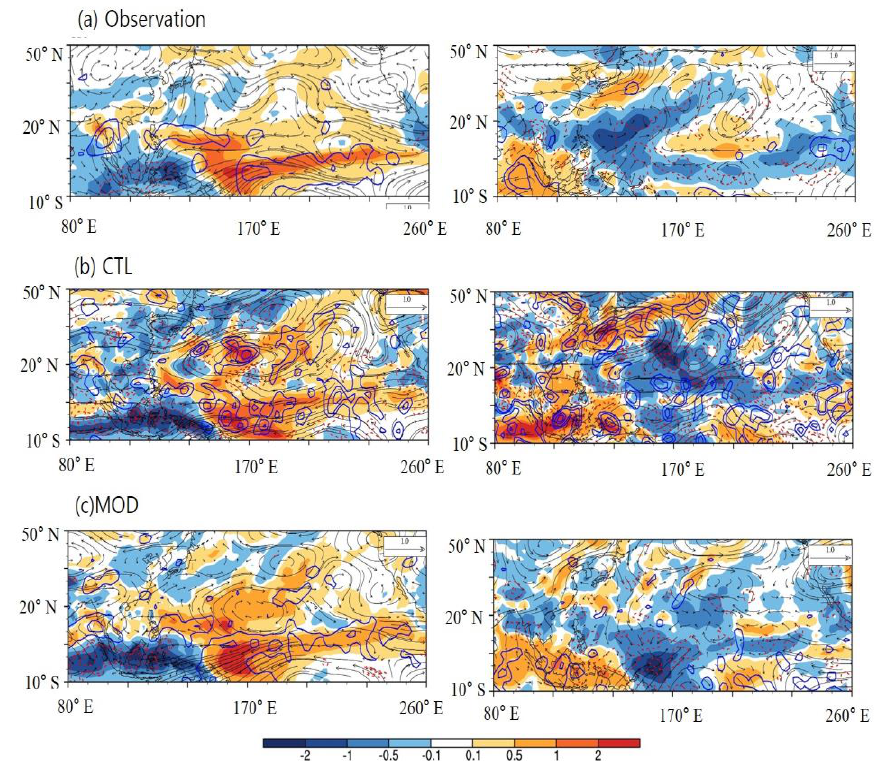
Figure 11. Composite maps of JJA rainfall (shading, mm day − 1 ), divergence (blue contour, day − 1 ), convergence (red contour, day − 1 ) and 200 hPa winds (vector, m s − 1 ) anomalies from: ( a ) observation; ( b ) CTL; and ( c ) MOD during El-Nino developing (left panels) and decaying year (right panels). The contour starts from ±0.02 and intervals are 0.04.